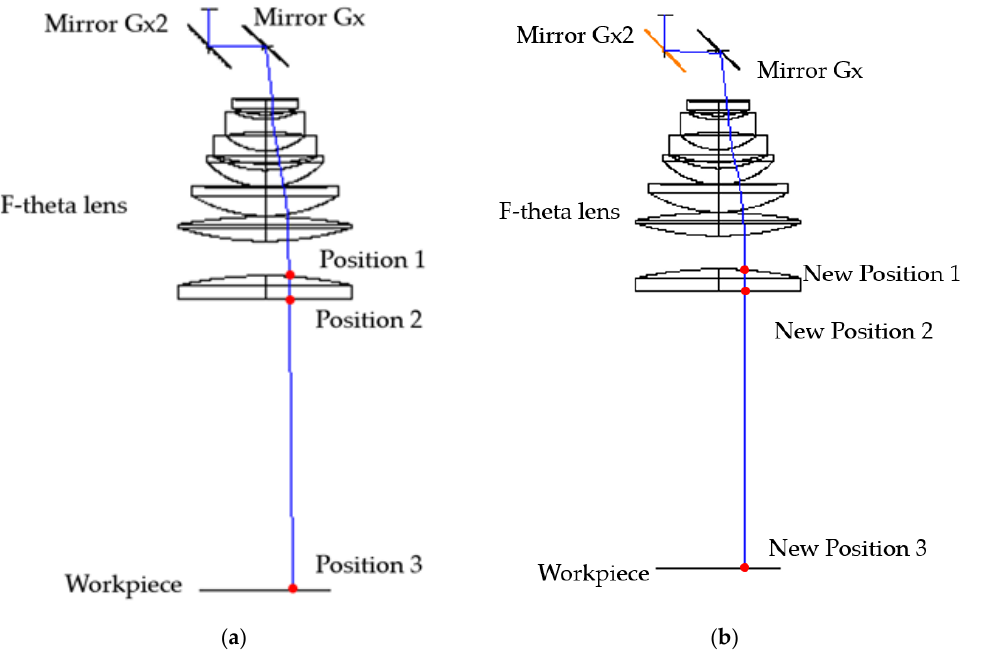
Figure 3. Illustration of the working principle of a 1D scanning system using two mirrors ( a ) before and ( b ) after telecentricity compensation with mirror Gx2 in orange, simulated by Zemax. A position coefficient C f − theta is defined as the coefficient to determine the new position one of the f-theta lens P 1n from position one P 1 , and it depends on the structure of the f-theta lens.